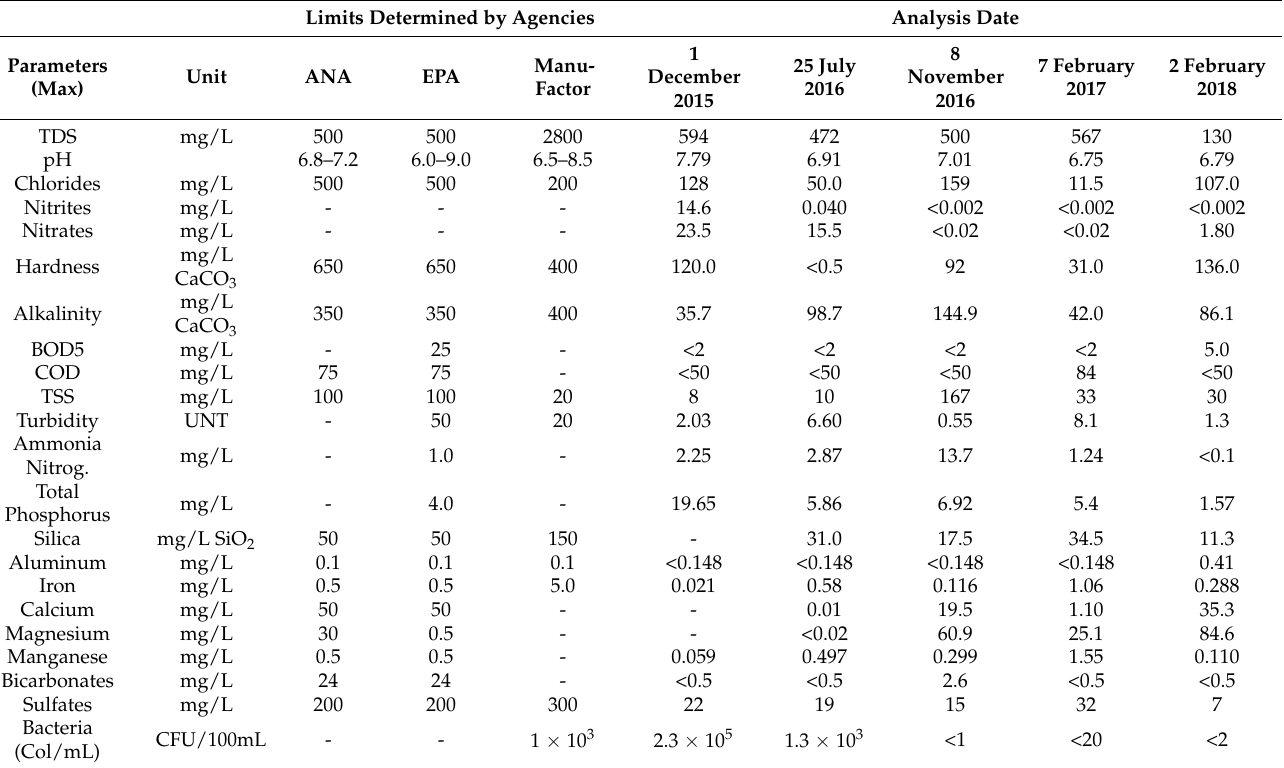
Table 2. Reference parameters and results obtained during monitoring of wastewater